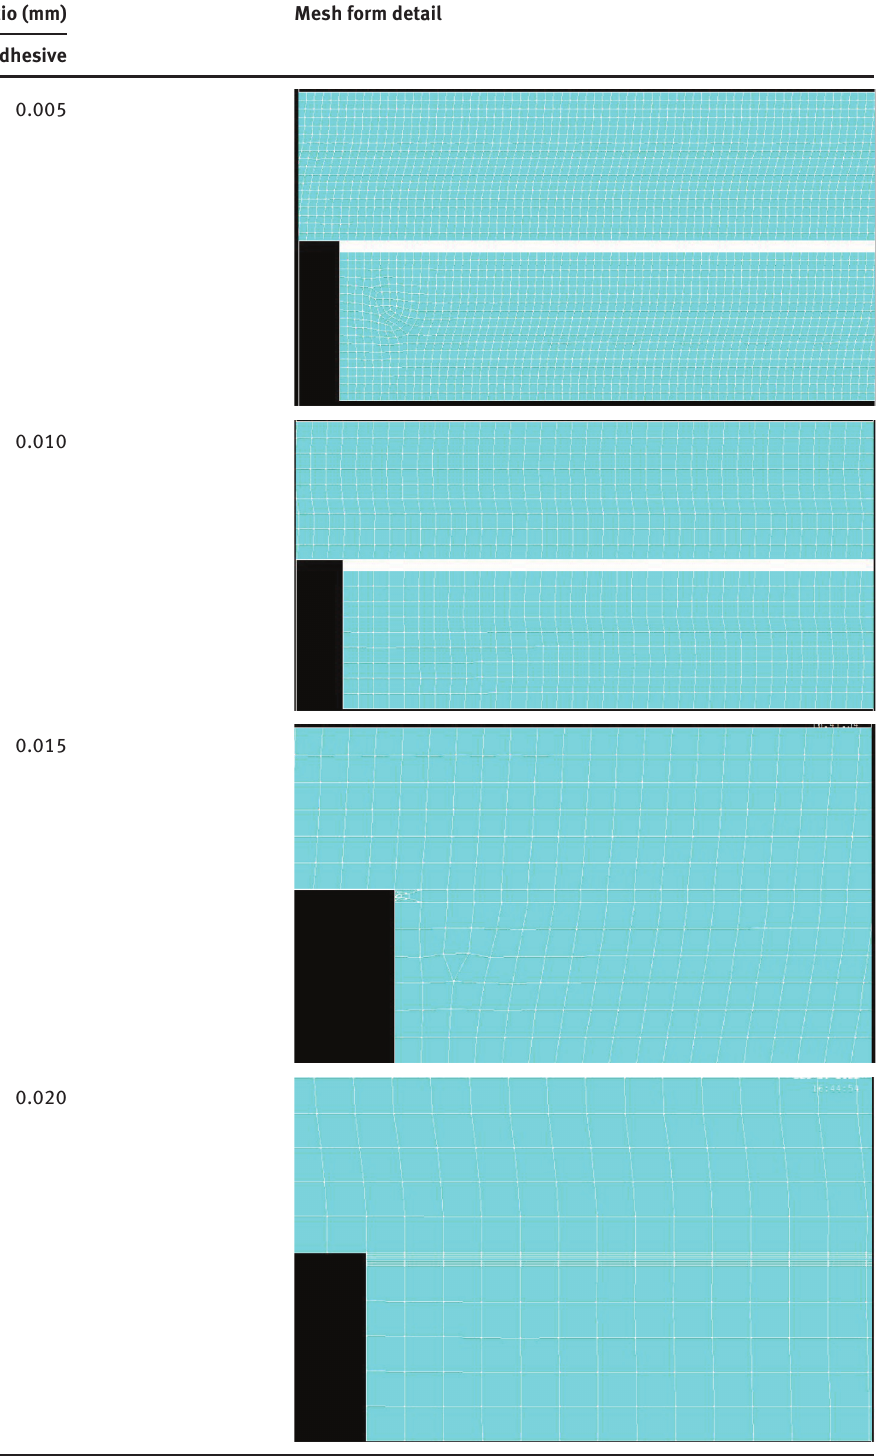
Table 5 Mesh detail for stress singularity region A with different element